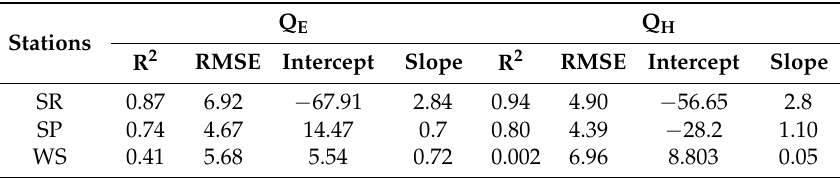
Figure 3. Spatial variation of monthly average of atmospheric stability based on the Richardson number from July 2001 to December 2014. Table 4. Summary of R 2 , RMSEs and coefficients of monthly average Q E and Q H measured by eddy-covariance method versus modeled from bulk aerodynamic using data from Stannard Rock lighthouse, Spectacle Reef lighthouse, and White Shoal lighthouse (W · m − 2 ).